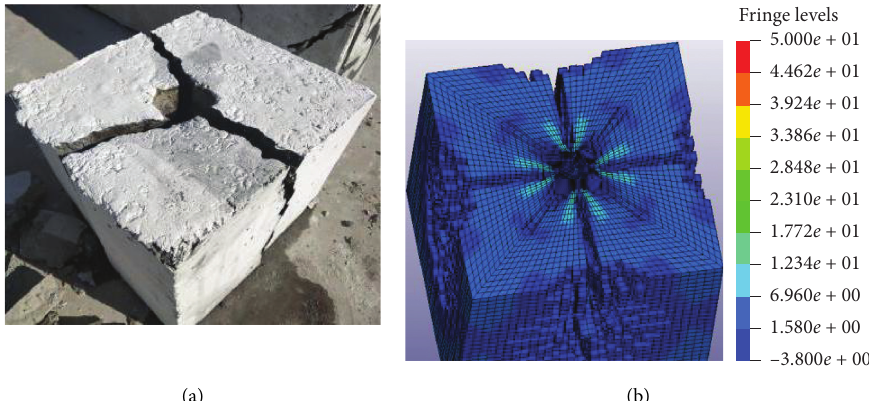
Figure 5: Comparison of experimental results and simulation results for a concrete block. (a) The test result. (b) The simulation